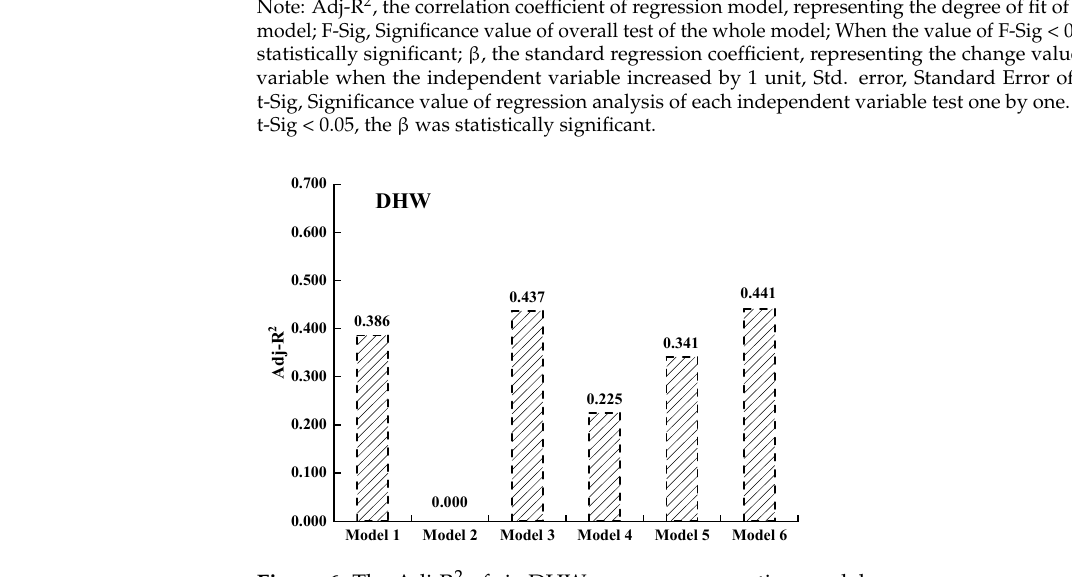
Figure 6. The Adj-R 2 of six DHW energy consumption models.